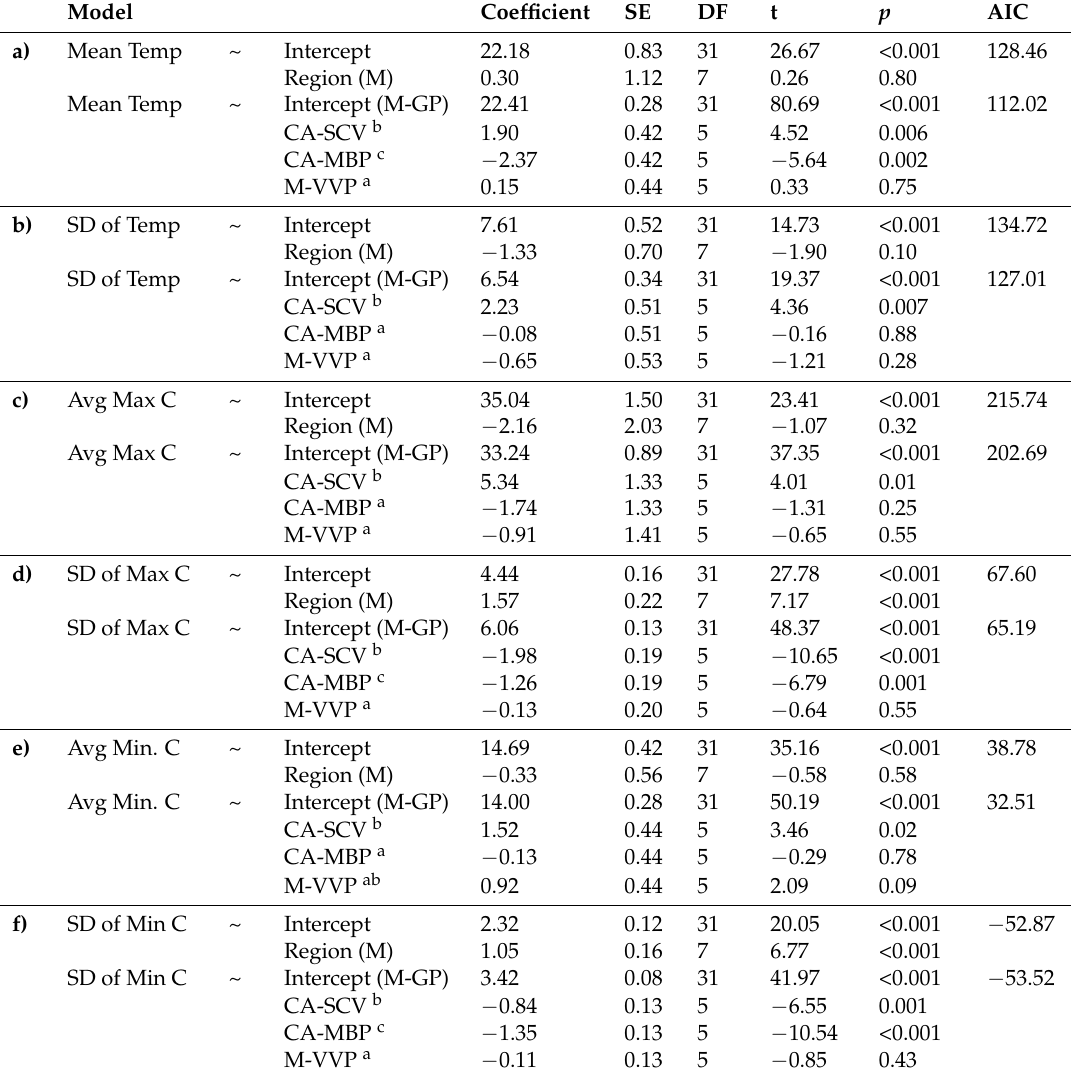
Table 3. Analysis of measured temperature variables in gardens (logger data) as a response to region and ecoregion. Reference level (the level of contrast) for region models is Melbourne, and reference level for ecoregion models is the Gippsland Plain; model intercepts represent estimates for these reference levels (Melbourne and Gippsland Plain, respectively). The superscripted letters (a,b,c) indicate significant differences ( P ≤ 0.05) among ecoregions assessed through post-hoc comparison tests. (CA, California; M, Melbourne; MBP, Monterey Bay Plains; SCV, Santa Clara Valley; VVP, Victorian Volcanic Plain; SE, standard error; DF, degrees of